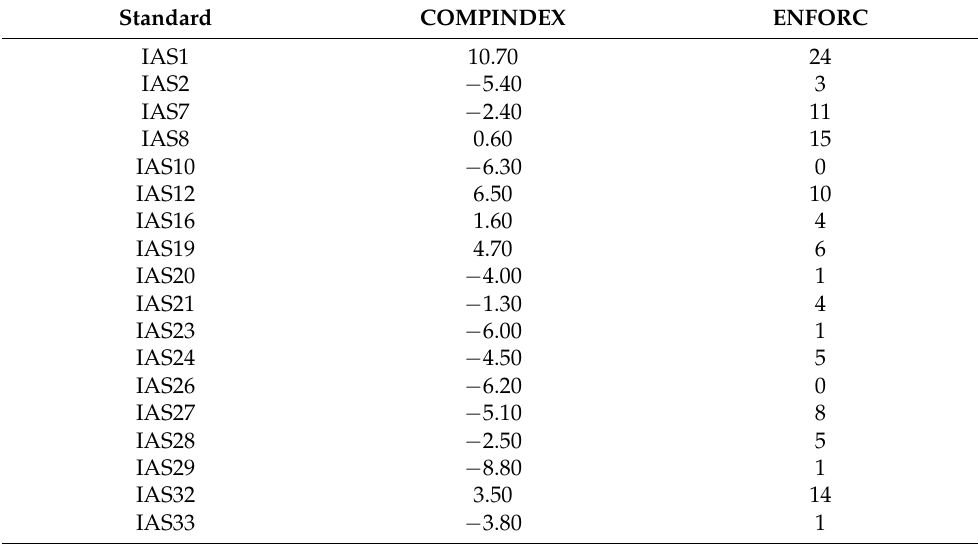
Table 2. Complexity score and list of decisions of